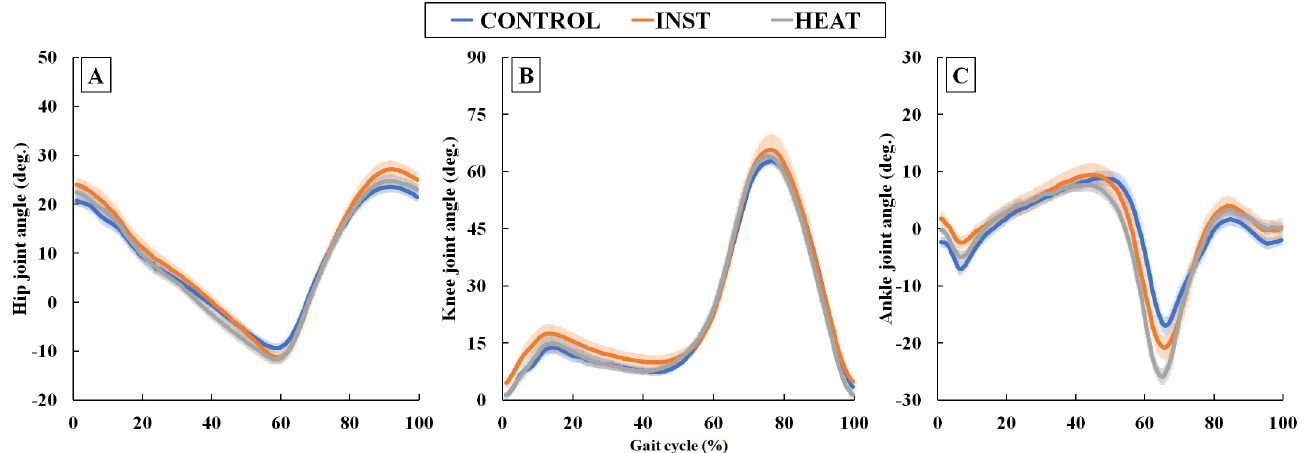
Figure 4. Changes in the angles of hip ( A ), knee ( B ), and ankle ( C ) movements in the sagittal plane during the gait cycle for the CONTROL, INST and HEAT condition in post-task (Values are means ± standard errors of mean). The definitions of each joint angle are shown in Figure 2.